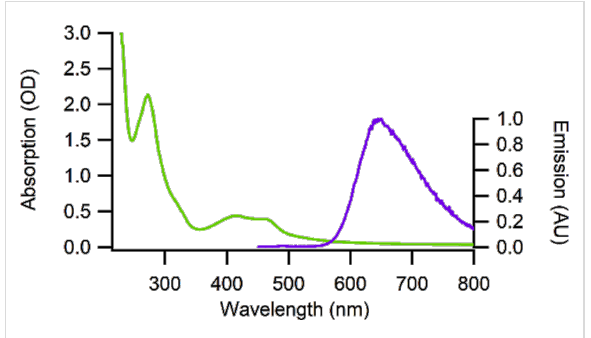
Figure 3: Absorption and emission spectra of Ru II -calix[4]arene- [c-(RGDfK)] 4 conjugate 9 in water.